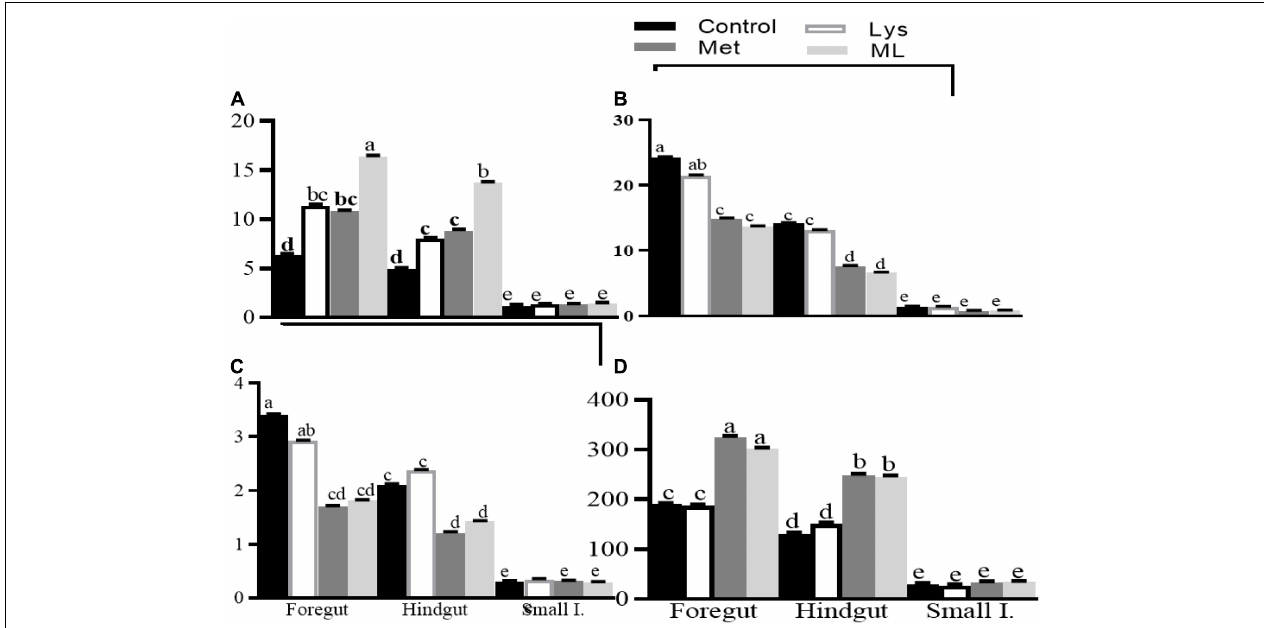
FIGURE 3 | Least square and standard error of means (SEM) on microbial fermentation metabolites (A) ammonia production (mM), (B) dissolved hydrogen (dH 2 ; µ M), (C) dissolved methane (dCH 4 ; mM), and (D) dissolved hydrogen sulfur (dH 2 S; mM) in different gut regions of goats in response to amino acid supplements. Different letters for the dietary treatments within each gut region indicate significant differences at p < 0.01.